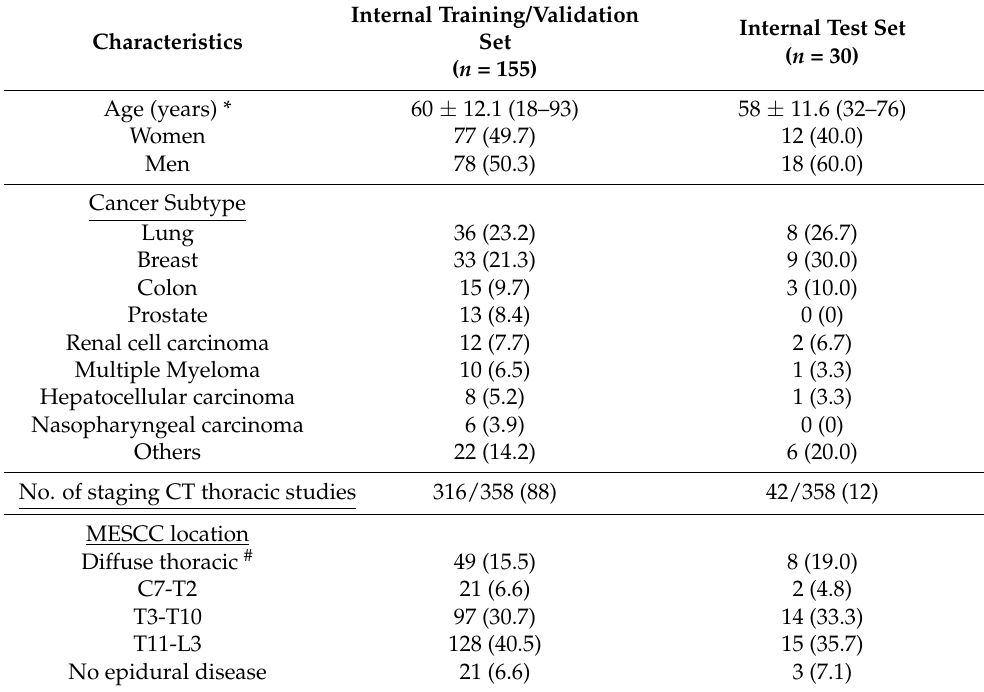
Table 1. Patient demographical data and characteristics for the deep learning model train- ing/validation and test